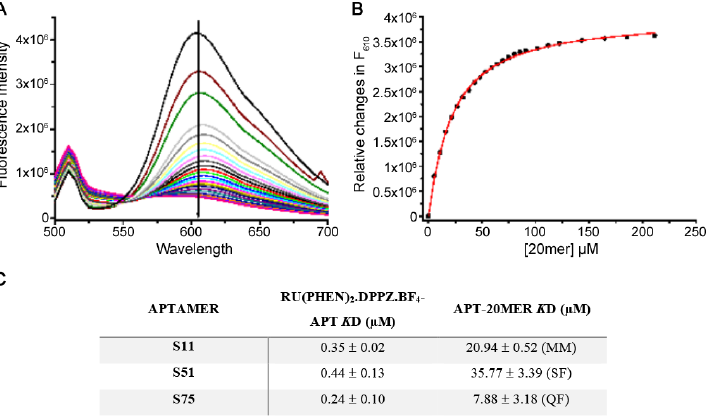
Figure 2. Fluorescence changes observed upon titration of the 20mer into the S11 aptamer-dye com- plex. ( A ) Emission spectra; ( B ) Fluorescence changes plot as a function of 20mer concentration. All experiments were performed in duplicate and the results presented are the average of these meas- urements; ( C ) Dissociation constants obtained from the Ru (II) complex displacement assay. Data for the aptamer-dye complex were all fit to a sigmoidal function while data for the aptamer-peptide complex best fit to differing functions: MM = standard hyperbolic function described by the Mich- aelis–Menten equation; SF = sigmoidal fit; and QD = quadratic function for binding. However, we used the same experiment to demonstrate the aptamer specificity, test- ing our aptamers against the Variable Tandem Repeat (VTR) sequence of the MUC1 and a non-related protein (lipase). We showed that at least 100-fold more MUC1 peptide was necessary to displace the Ru (II) complex, whereas lipase was not capable of displacing the Ru (II) complex up to the concentration tested (250 µM) (Supplemental Figure S2). 3.4. Thermal Denaturation Assay Determination of the melting temperature can be employed to assess the effects of any modifications made to a nucleic acid or an interaction with a ligand in terms of stabi- lization or destabilization of the secondary structure of this nucleic acid. In order to determine the thermal denaturation of the MUC1/Y aptamers, the fluo- rescence analysis approach was employed using the HRM SYBR green dye, as this tech- nique is considerably more sensitive than the UV absorbance method. Each aptamer of the S11 series (S11a, S11b and S11c) was incubated with the peptides (10mer and 20mer), short peptides without any secondary or tertiary structure, in a 1:1000 molar ratio, in a binding solution for 1 h at ambient temperature. Upon incubation, the SYBR green dye was added to the aptamer solution and incubated for 30 min on ice. Thermal denaturation cycles (TDCs) were performed three times from 3 °C to 100 °C at a rate of 1°C/min with a gradual renaturation process between each cycle. The emission was detected at 520 nm when excited at 497 nm. Figure 3 shows plots for S11a (A) and S11a with the 20mer peptide (B) at each TDC. In the case of S11a (Figure 3A), minimal variation in fluorescence was observed between the three TDC. When S11a was incubated with the 20mer peptide (Fig- ure 3B), on the other hand, the fluorescence value at the beginning of the analysis was slightly lower compared with the free aptamer (Figure 3A). However, dramatic changes in fluorescence were observed during the second and third TDCs, where the fluorescence values at the beginning of the cycle were 0.5 and 0.2, respectively. This effect suggests that the peptide inhibits the renaturation of S11a, resulting in the aptamer remaining mainly in an open conformation. A similar trend of a gradual decrease in fluorescence through each cycle was also observed when the 10mer peptide was used (data not shown).